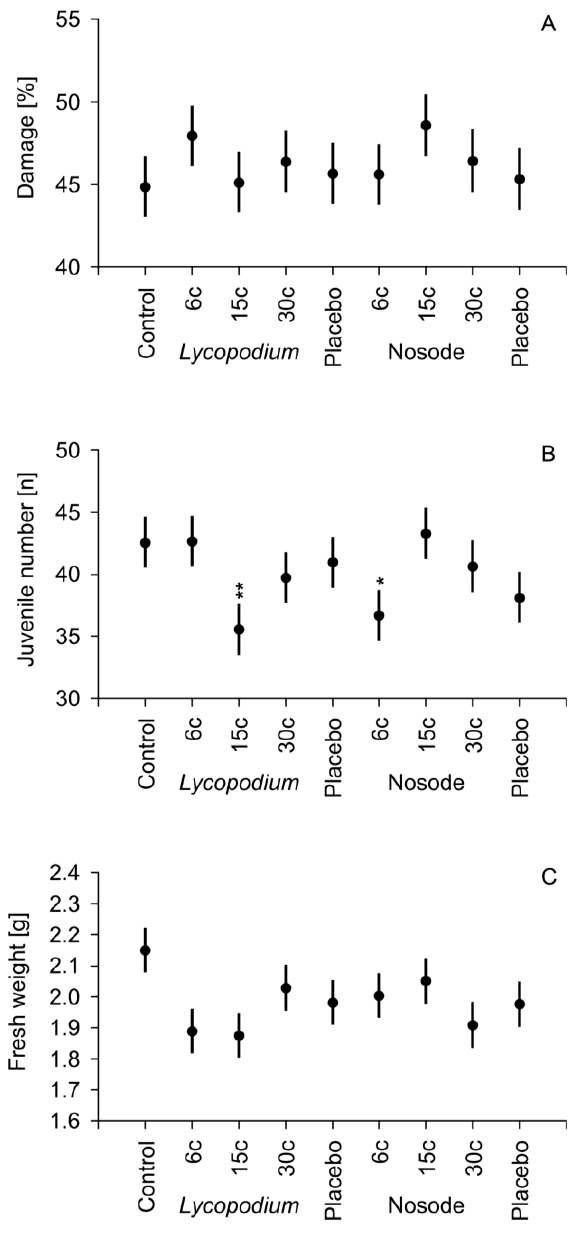
FIGURE 1 . Effects of a curative homeopathic treatment on apple seedlings inoculated with the rosy apple aphid: final assessment of L. clavatum or a nosode at the potency levels 6c, 15c, or 30c, or placebo granules after 17 days. (A) Percentage of damaged leaves; (B) number of juvenile offspring (n); (C) fresh weight (g). Mean values ± standard errors of six independent, randomized, and blinded experiments. Statistical evaluation with LSD test, compared to the untreated control: ** p < 0.01, * p <